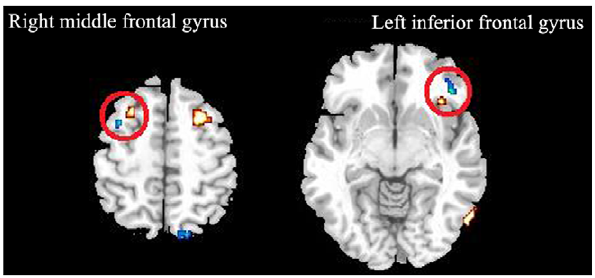
Figure 3. Overlap between the morphometric (red regions) and functional (blue regions) results. Though the decreased ALFF in the right middle frontal gyrus and left inferior frontal gyrus (Within red circle) were found quite near the decreased GMV in the same region, the ALFF in these regions did not correlate with the GMV.